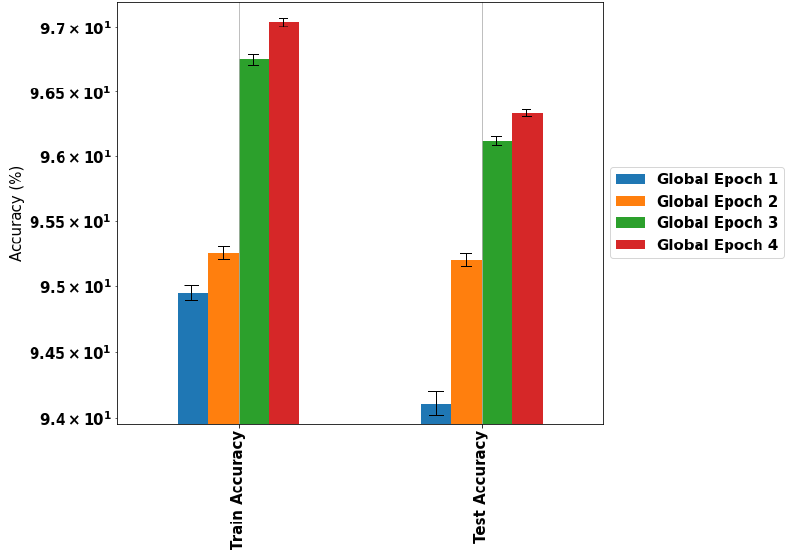
Figure 11. Experiment 3.3: Local learning effect with three agents, five local epochs, and four global